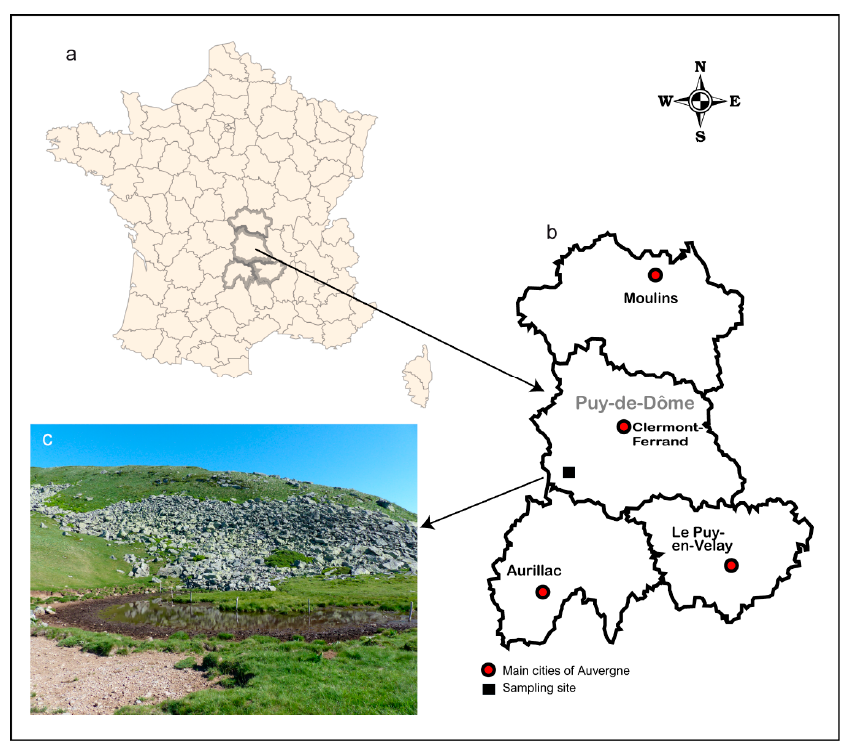
Figure 1. Map of the studied site. ( a,b ) General location map of the study area where Laqui du Seignavoux is located (square); ( c ) photograph of the Laqui du Seignavoux in June 2017. Diversity 2020 , 12 , x FOR PEER REVIEW